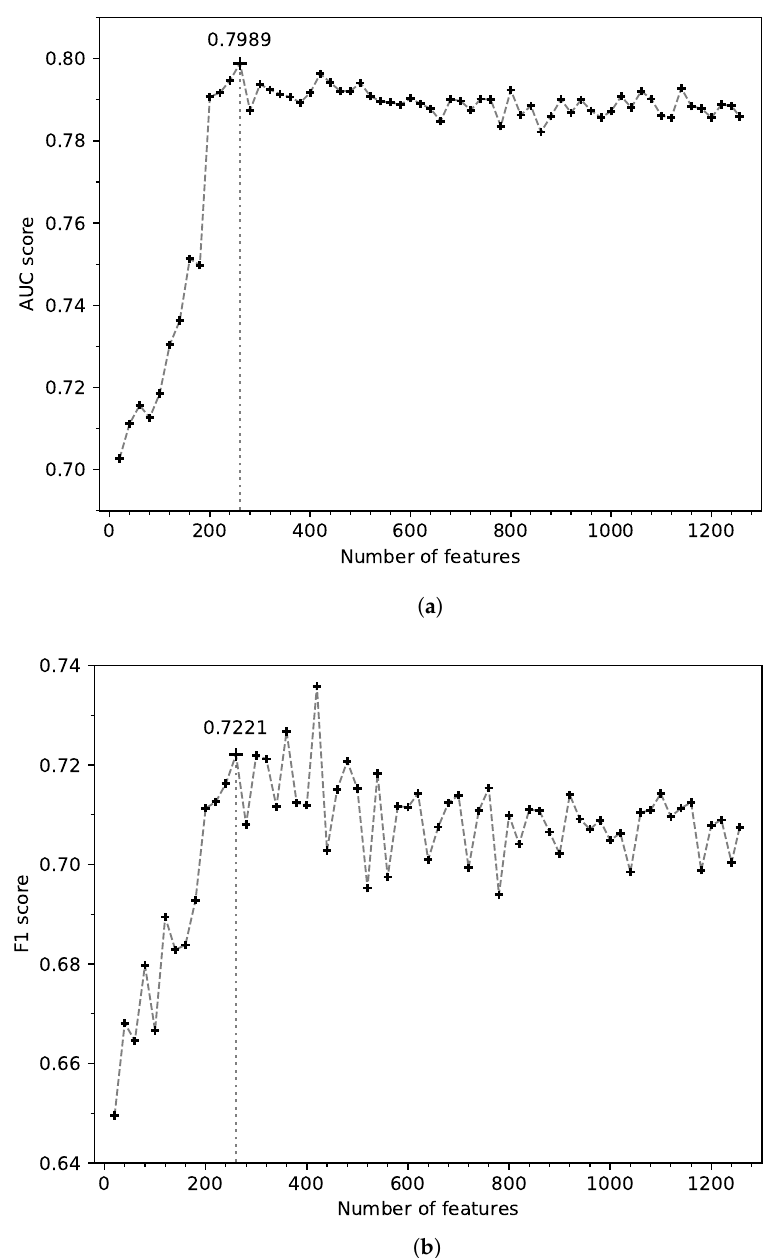
Figure 1. The performances on the validation dataset with different numbers of features in the second stage of the feature-selection method. ( a ) The AUC scores on the validation dataset of CSF proteins. ( b ) The F1 scores on the validation dataset of CSF